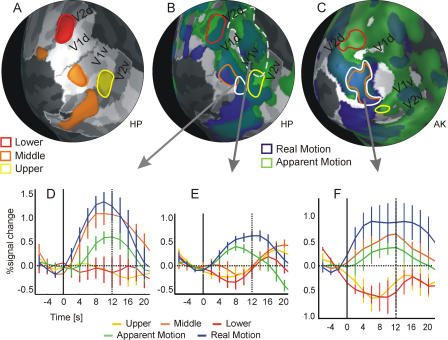
Activation Pattern in V1 for Experiment 1Medio-posterior view on the inflated left occipital cortex of subject HP (A and B) and subject AK (C). All five subjects are shown in Figure S1. Gray-scale coloring of cortex indicates the extent of retinotopic visual areas (light gray: V1 and V3/VP; dark gray: V2, V4, and V3A) and the gyral pattern (concave surfaces are indicated in darker gray in the respective areas).(A) The cortical representations of the mapping stimuli are marked in color. The maps were obtained by calculating a balanced contrast between the respective mapping condition of interest and the two other mapping conditions (e.g., middle versus upper and lower). The thresholds of t-maps were individually adjusted to obtain patches of comparable size in V1: upper (yellow), t(600) > 9.3; middle (orange), t(600) > 11.9; and lower (red), t(600) > 15.1 (all p << 0.001).(B) Cortical activation maps for the apparent-motion (green) and real-motion (blue) condition compared to baseline (apparent motion in V1: t[600] > 3.6, p < 0.0004; real motion in V1: t[600] > 18.6, p << 0.001). Cortical representations of the mapping stimuli are indicated by colored outlines taken from (A). The solid white line indicates a patch of significant activation (t[600] > 3, p < 0.003) for the following conjunction of contrasts, which represents the ideal activation pattern: (middle > upper) and (middle > lower) and (apparent motion > upper) and (apparent motion > lower). The dashed white line marks a peripheral region in V1 with significant activation in response to apparent motion and real motion.(C) Same as (B) for subject AK. The white region with the optimal response pattern overlaps largely with the representation of the middle stimulus (in orange; see Figure S1 for details).(D) Event-related BOLD signal change for subject HP plotted over time from the patch outlined by the solid white line in (B) (solid black line indicates stimulus onset, dotted line stimulus offset).(E) Event-related BOLD signal change of the apparent-motion-activated (green) region from the eccentric parts of V1 outlined by the dashed white line in (B) (solid black line indicates stimulus onset, dotted line stimulus offset). This eccentric region responds to real motion and apparent motion but not to the middle stimulus.(F) Same as (D) for subject AK.Error bars correspond to standard errors of the mean.